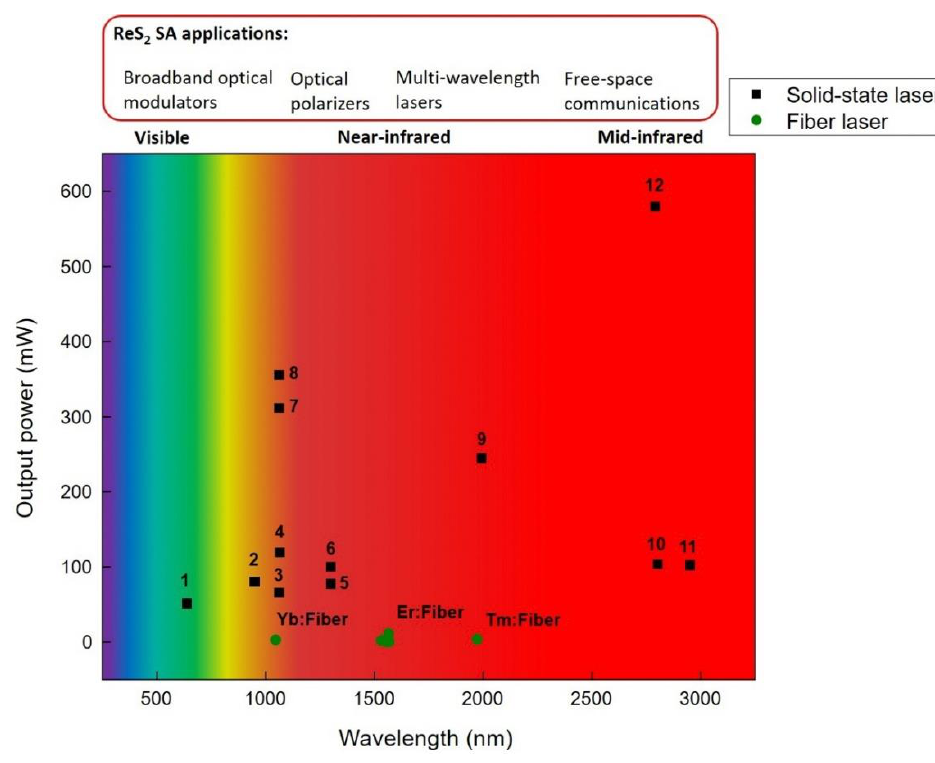
Figure 17. Spectral coverage for several types of pulsed fiber lasers and solid-state lasers generated by ReS 2 SA along with the corresponding output power. 1, Pr:YLF crystal [123]: 2, Nd:YAG crystal [71]: 3, Nd:YAG crystal [69]: 4, Nd:YAG crystal [123]: 5, Nd:YAG crystal [70]: 6, Nd:YAG crystal